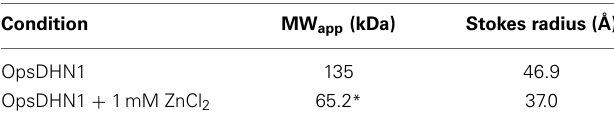
Table 1 | Apparent molecular weight and Stokes radius of OpsDHN1 as determined by size-exclusion